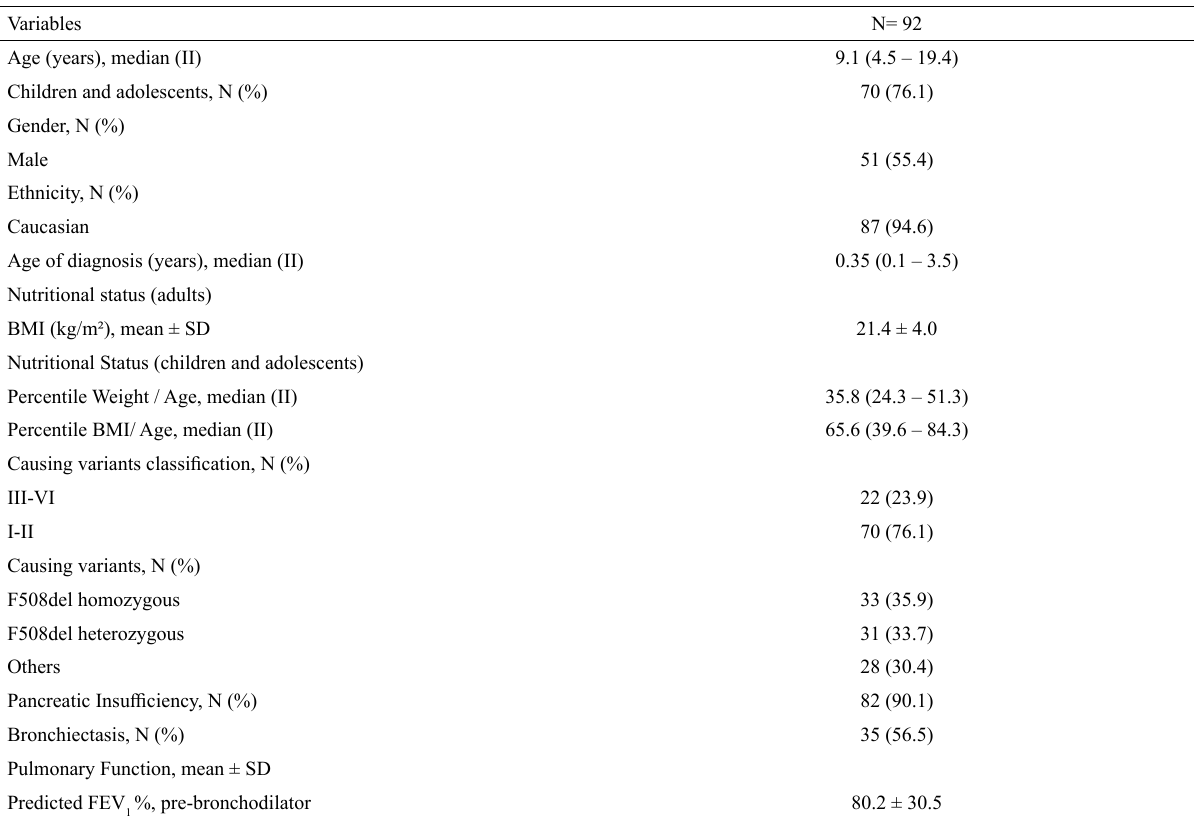
Table 1 – General characteristics of patients with Cystic Fibrosis in follow-up at the reference center for CF of São Lucas Hospital (PUCRS). Variables